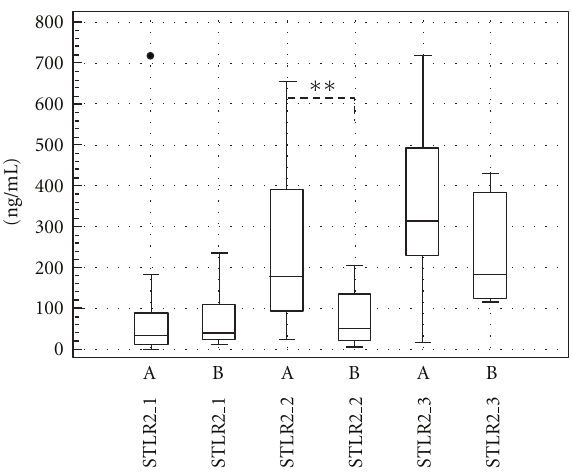
Figure 3: The concentration of soluble TLR2 (ng/mL) in pleural e ff usion fluid at three sampling points in prognostic favourable group of patients (A) and prognostic unfavourable group of patients (B): 1—before thoracoscopic procedure, 2—2 hours after terminating talc insu ffl ation procedure, 3—24 hours after talc insu ffl ation procedure. (Line: median; boxes: quartiles; whiskers: nonoutliers range.) Significance: ∗ P = 0,05–0,01; ∗∗ P = 0,01–0,001; ∗∗∗ P <